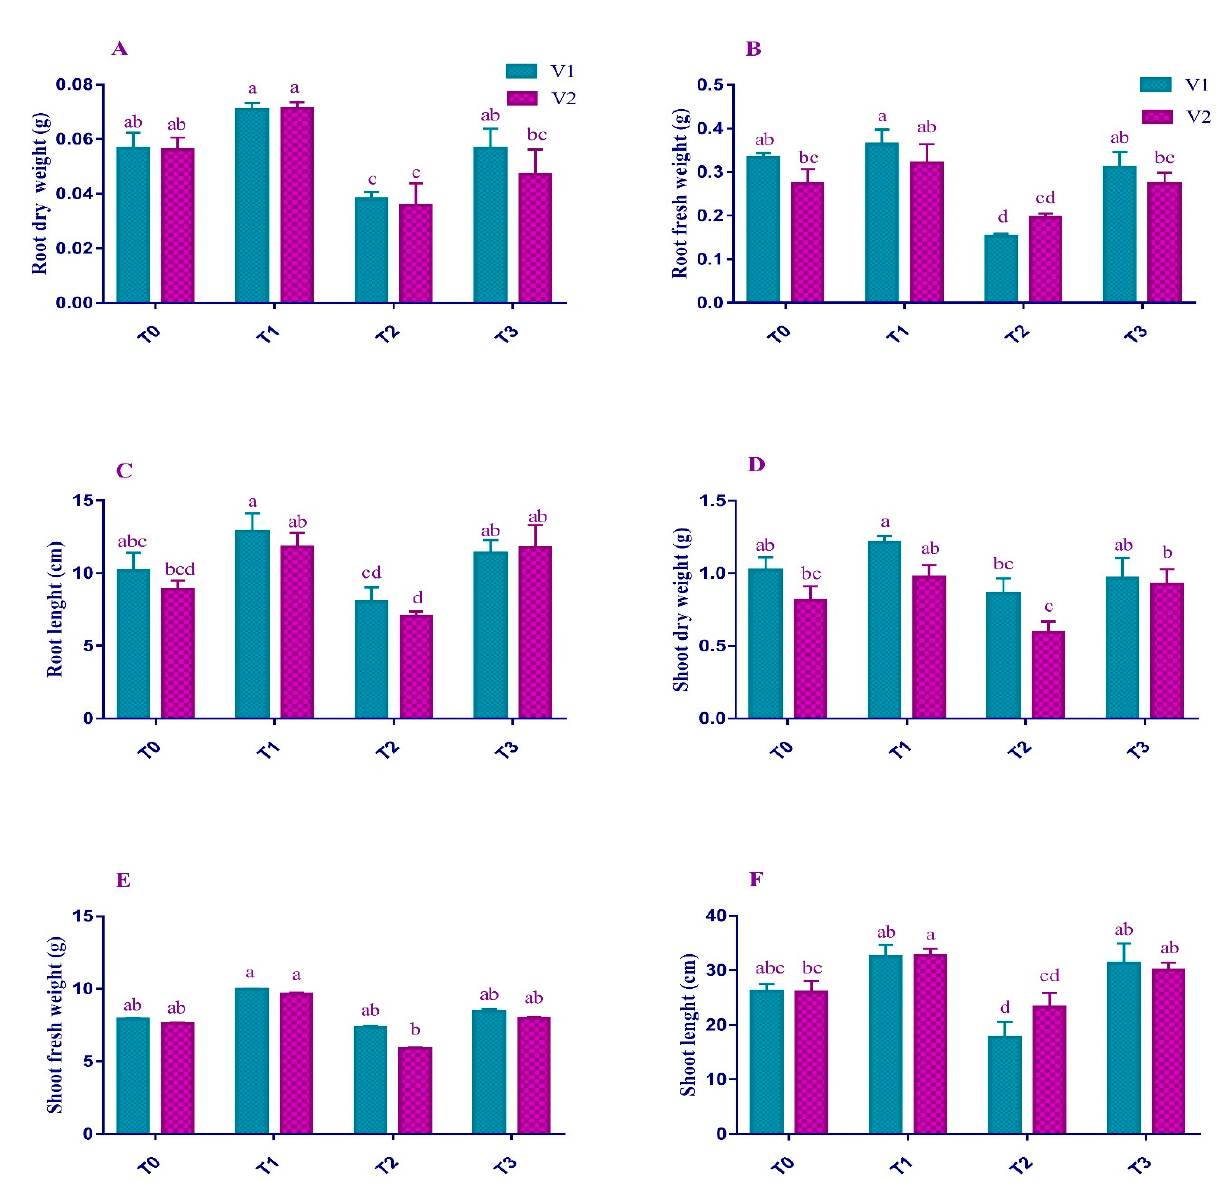
Figure 1. Effect of Pb and EDTA on ( A ) root dry weight (g), ( B ) root fresh weight (g), ( C ) root length (cm), ( D ) shoot dry weight (g), ( E ) shoot fresh weight (g) and ( F ) shoot length (cm) of brown mustard. Error bars above indicate the ± SE of three replicates. Means sharing the same letter for a parameter do not differ significantly at p ≤ 0.05. V1 = Faisal cultivar; V2 = Rohi cultivar; T 0 = 0 mM EDTA + 0 mM Lead acetate; T 1 = 2.5 mM EDTA + 0 mM Lead acetate; T 2 = 0 mM EDTA + 0.5 mM Lead acetate; T 3 = 2.5 mM EDTA + 0.5 mM Lead acetate.